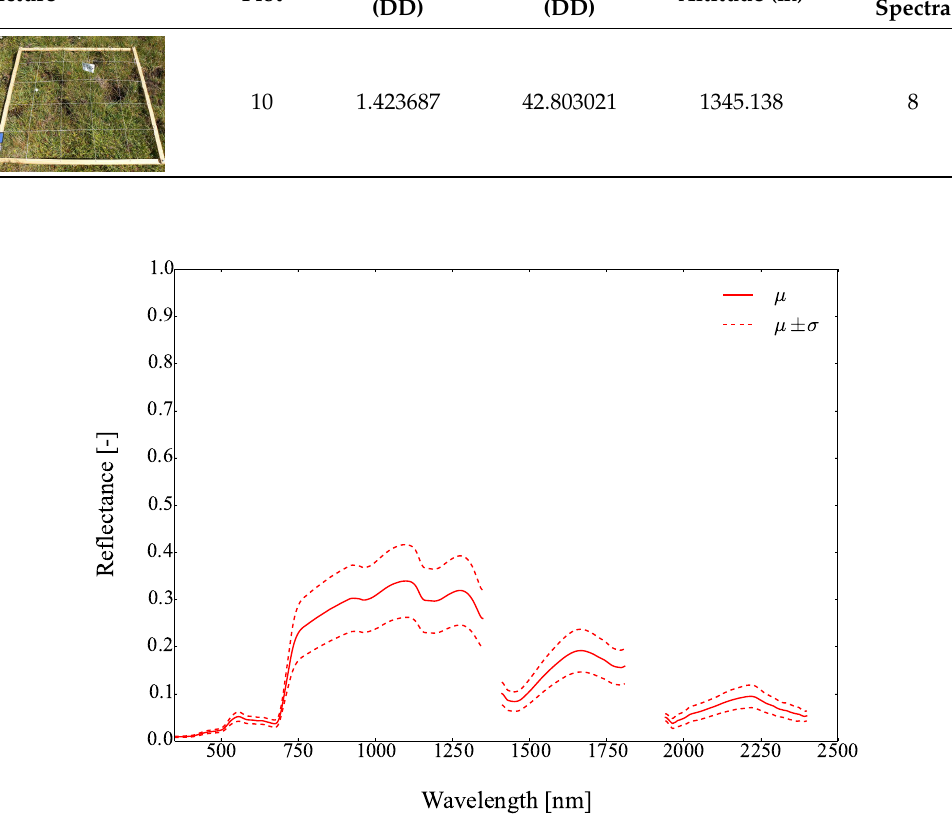
Figure A8. Mean reflectance ( µ ) and standard deviation ( σ ) of Pinguicula sp.